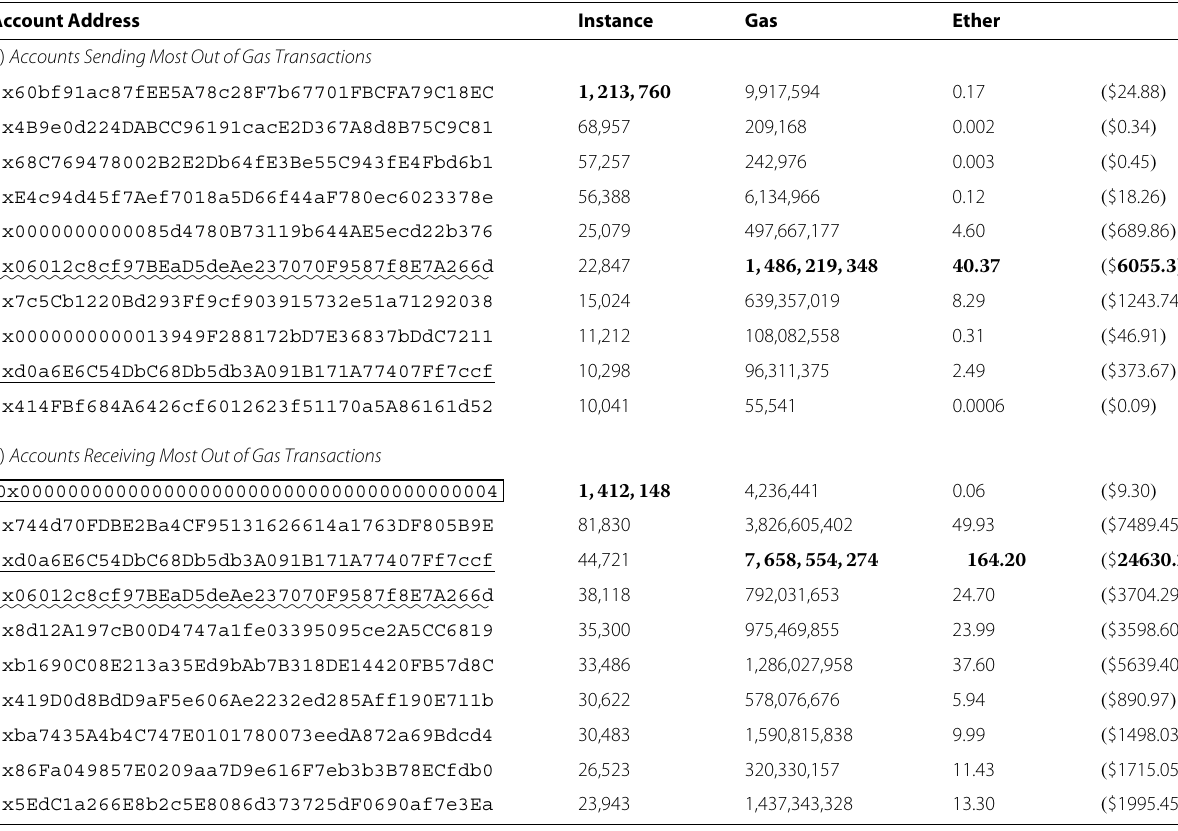
Table 3 A list of top 10 accounts sending and receiving most out of gas